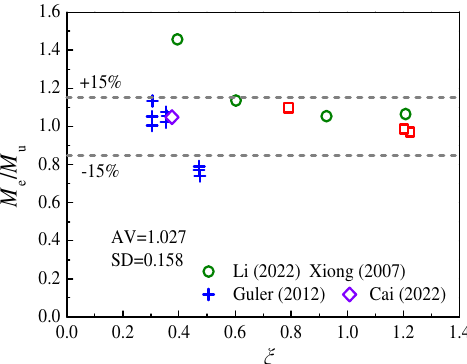
Figure 17. The comparison of predicted M u in this work with test results. (Guler et al. [37], Cai [38], Li et al. [42], Xiong et al. [43])